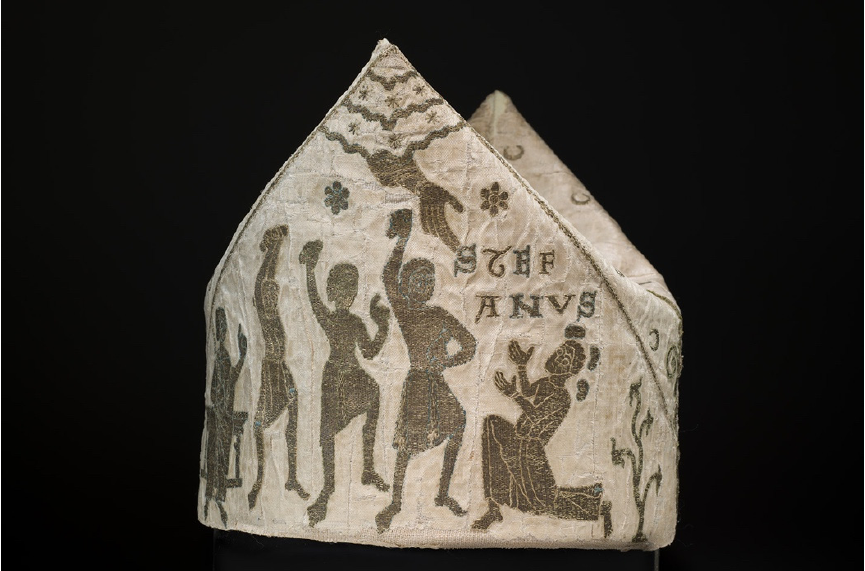
Figure 4. Seligenthal Mitre. rear face with the Stoning of St Stephen. Munich, Bayerisches National- museum, Germany. © Munich, Bayerisches Nationalmuseum.